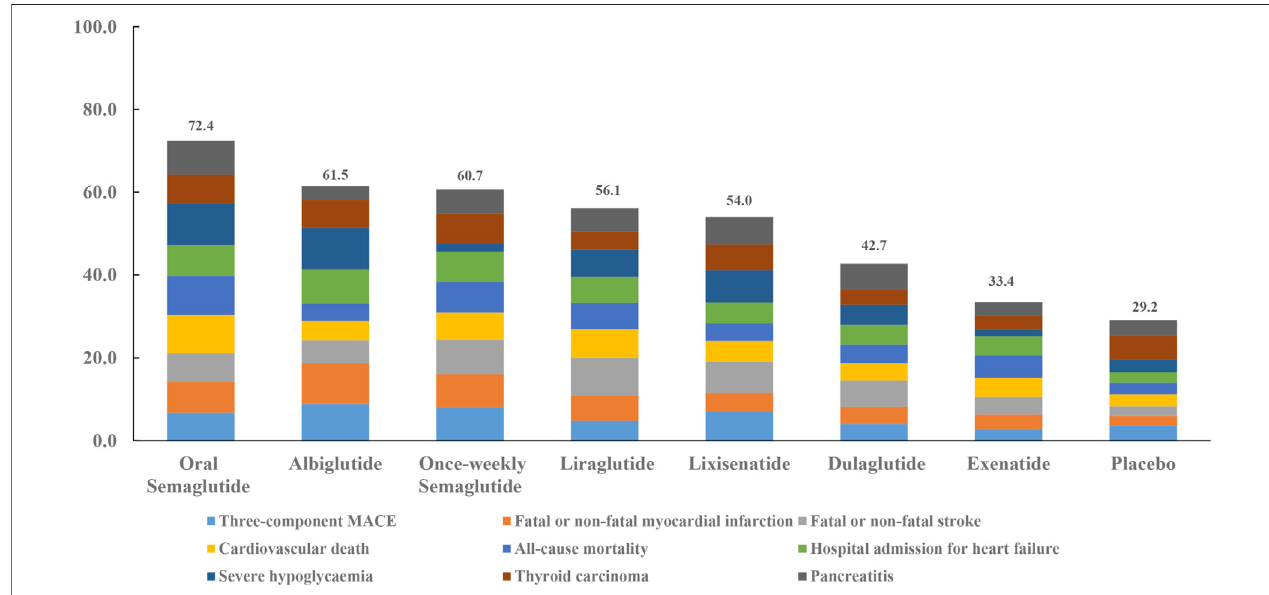
FIGURE 3 | Ranking of treatments according to nine primary outcomes. Cumulative percentages after normalization (0 – 100%) are shown in the key. Each intervention was scored with points up to a maximum of 11.1 for each primary outcome (overall maximum score, 100) with data from rankograms and SUCRAs.